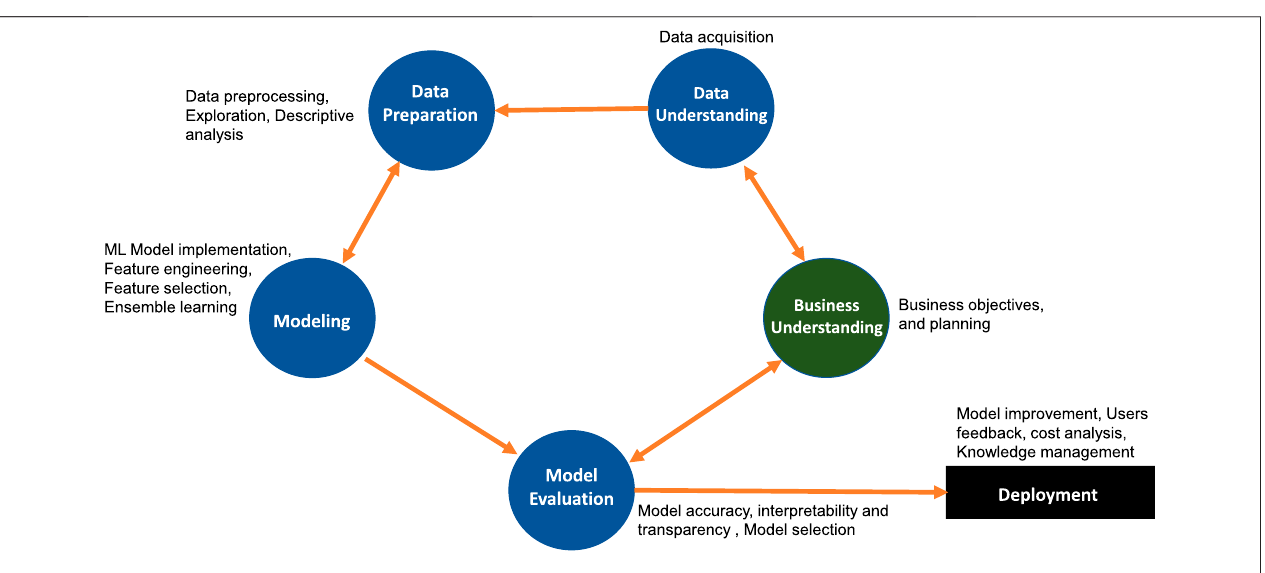
FIGURE 1 | The CRISP-DM framework describes a cyclic process of a data analysis